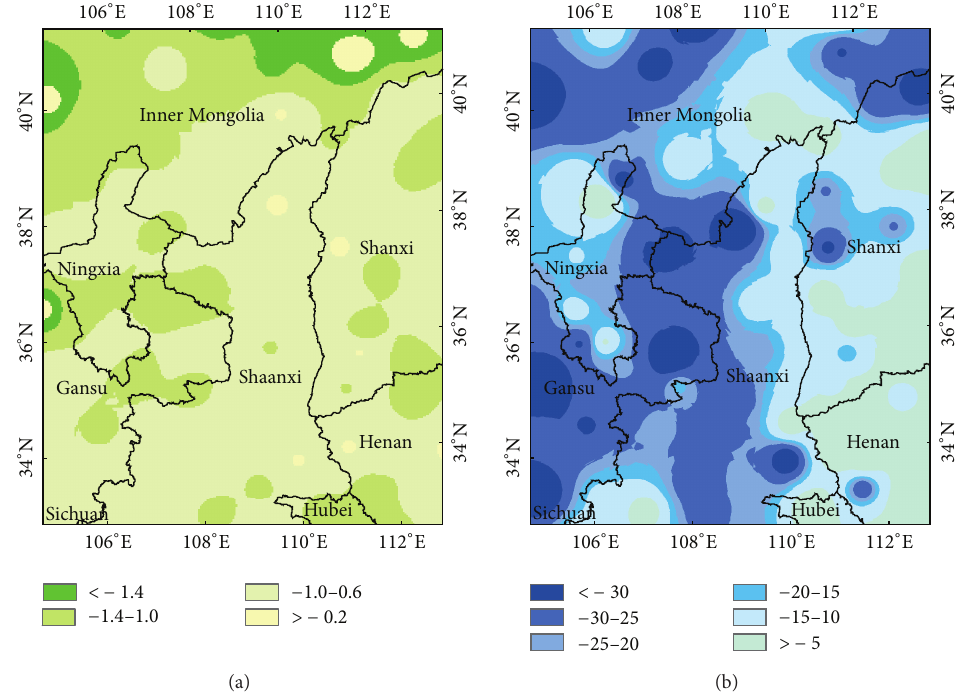
Figure 4: Difference between the simulated and observed annual average temperature ((a), unit: ∘ C) and annual precipitation ((b), unit: mm) in the overgrazing areas of Northwest China in